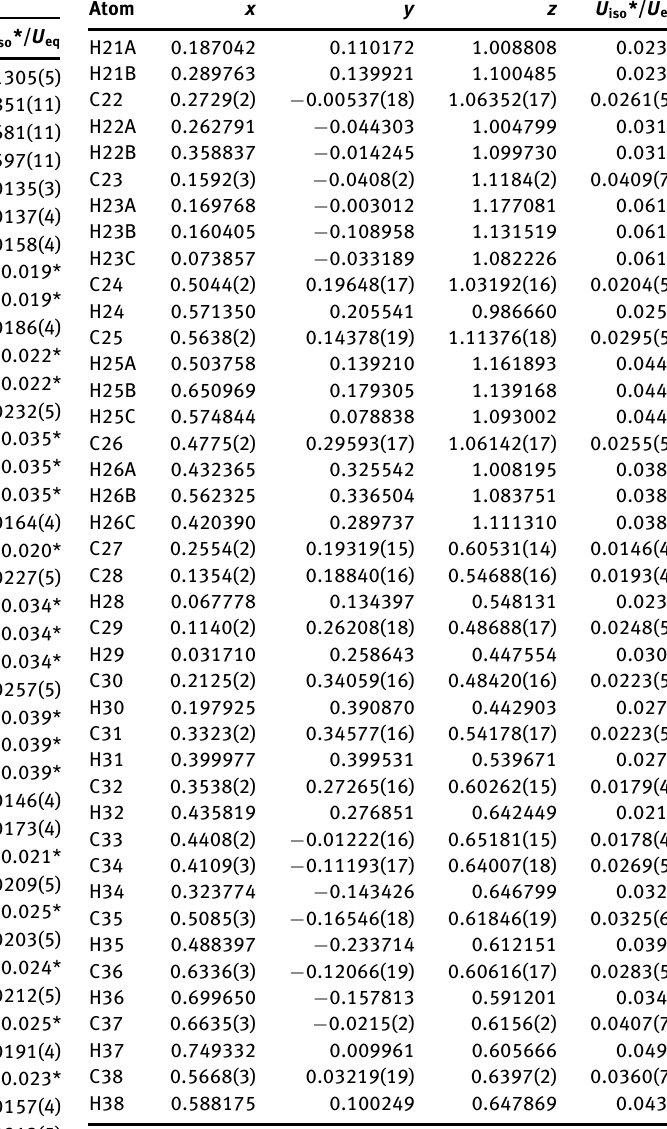
Table 2: Fractional atomic coordinates and isotropic or equivalent isotropic displacement parameters (Å 2